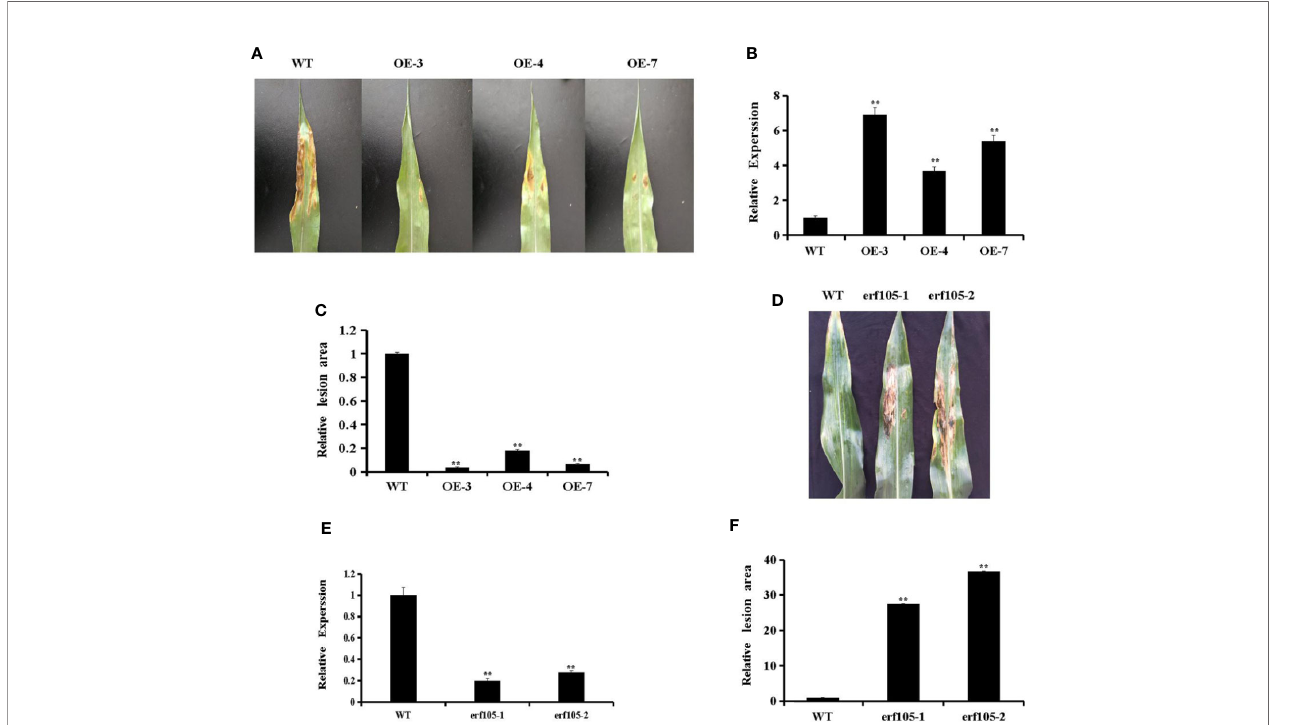
FIGURE 6 | Responses of ZmERF105 over-expression and erf105 mutant lines to E. turcicum . (A) Disease symptoms on the leaves of T 2 transgenic lines at 5 dpi. (B) Relative expression analysis of ZmERF105 in T 2 transgenic lines. (C) The relative lesion areas of the transgenic lines at 5 dpi. (D) Disease symptoms on the leaves of erf105 mutant lines at 5 dpi. (E) Relative expression analysis of ZmERF105 in erf105 mutant lines. (F) The relative lesion areas of the erf105 mutant lines at 5 dpi. The experiment was performed using three biological and technical replicates each and analyzed using Student ’ s t -tests (**P < 0.01). Bars indicate standard error of the mean